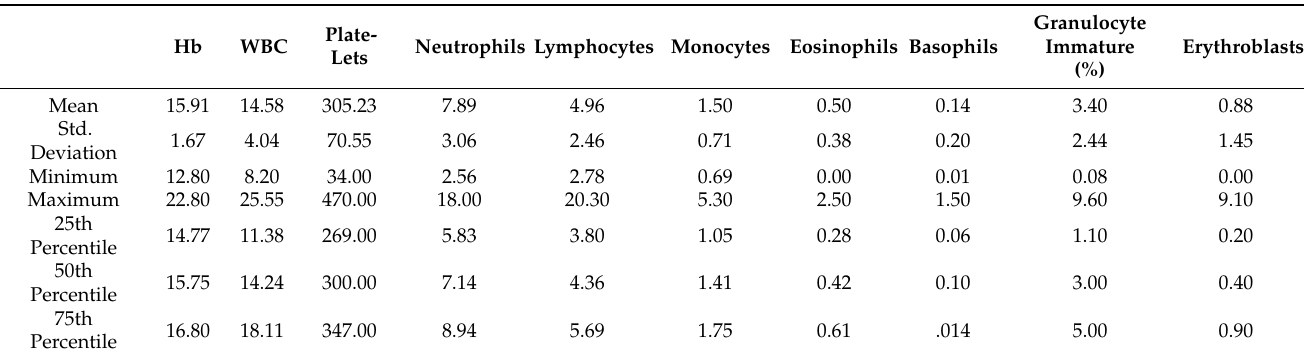
Figure 1. Maternal leucocyte subtypes. The hematological values in umbilical cord blood are shown in Table 3 and Figure 2. Table 3. Umbilical cord blood samples. Cell counts.